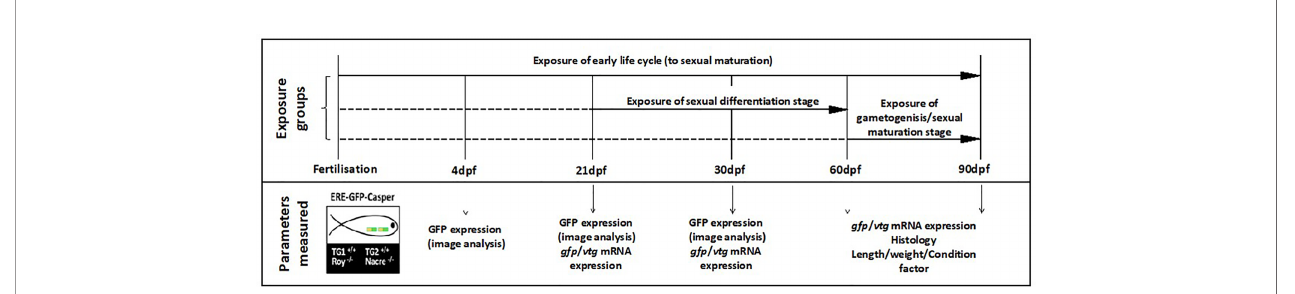
FIGURE 1 | Design of the zebra fi sh ef fl uent exposure experiment. Exposures were conducted to a system water control (SWC), EE2 (10 ng/L) or WwTW ef fl uent concentrations of 100% or 50% for the different developmental life stages indicated. Exposures are indicated with solid horizontal lines with dashed lines indicating fi sh maintenance in clean water. There were three replicate tanks per treatment. The time points for measurement of the different endpoints are indicated. From 0-4 dpf, embryos/larvae were housed in 500 mL glass dishes without any water fl ow at a density of 50 fi sh per dish and kept in an incubator at 28 °C. From 5-21 dpf, fi sh were kept in 3.5 L nursery tanks placed within the 20 L glass tanks and then subsequently transferred to the 20 L tanks at 21 dpf.